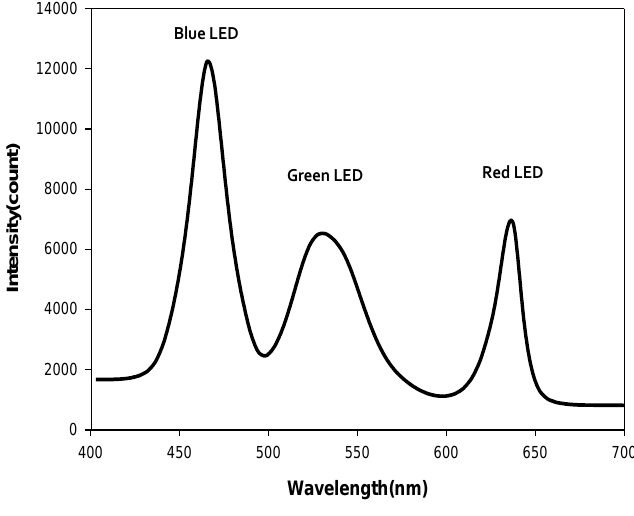
Figure 2. Spectra of the reference panel with blue, green, and red LED